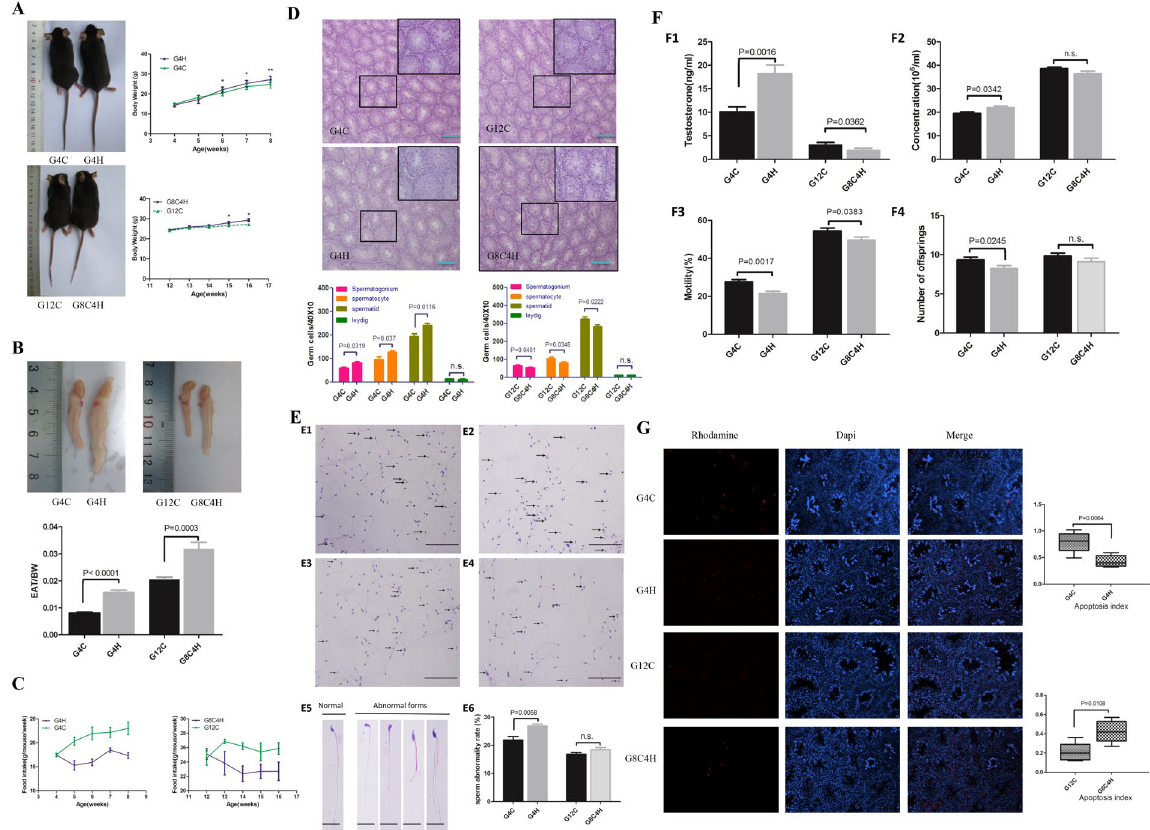
Figure 1. Description of mouse model established after mice were fed a HFD for 4 weeks and the influence of a HFD on IL1 β in the reproductive system of mice. ( A ) Representative pictures of G4H, G4C, G8C4H and G12C mice and comparison of time-dependent increases in bodyweight between G4H and G4C, G8C4H and G12C mice (n = 10 in each group). ( B ) Representative picture of epididymal adipose tissue and the epididymal adipose tissue to bodyweight ratio (EAT/BW) in the G4H and G8C4H groups compared to the control group. ( C ) Food intake in G4H (left) and G8C4H (right) mice compared with the corresponding control group. ( D ) Haematoxylin and eosin-stained mice testis sections from each group and the germ cell count. Scale bars = 50 μ m. ( E ) Sperm morphology analysis of G4C (E1), G4H (E2), G12C (E3) and G8C4H (E4) mice using HE staining. Arrows indicate abnormal spermatozoa. Scale bar = 50 μ m. (E5) Normal and abnormal spermatozoa in different forms; Scale bar = 10 μ m. (E6) Comparison of sperm abnormality in mice fed either a HFD or a CD. ( F ) Testosterone level (F1), sperm concentration (F2), sperm mobility (F3) and the number of offspring (F4) in G4H and G8C4H mice compared to G4C and G12C mice. ( G ) Germ cell apoptosis was tested use a TUNEL assay in G4H and G8C4H mice compared to G4C and G12C mice, respectively. Apoptotic germ cells are stained red (Rhodamine), and blue represents DAPI-stained nuclei. Merged images were produced using Image J software. Percentage of TUNEL-positive germ cell values are expressed as the mean ± SEM. * P < 0.05, ** P <